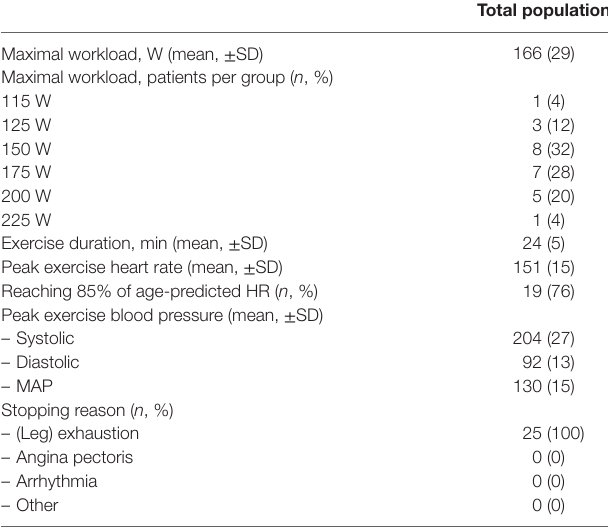
TaBle 3 | Exercise characteristics ( n = 25). TaBle 2 | Stress echocardiographic characteristics at rest and peak exercise